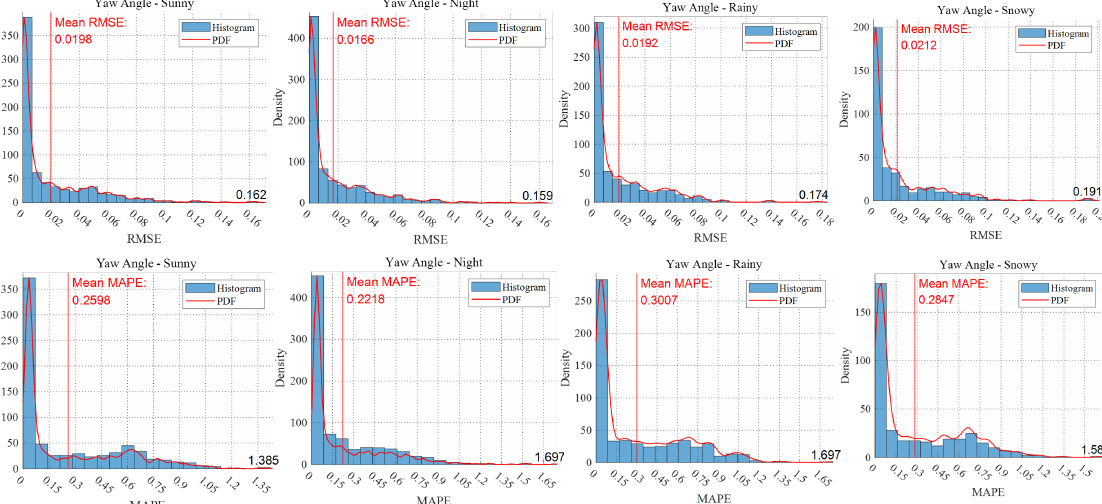
Figure 14. RMSE (first row) and MAPE (second row) histograms of extracted vehicle yaw angle under different weather conditions in the labeled MWUAV